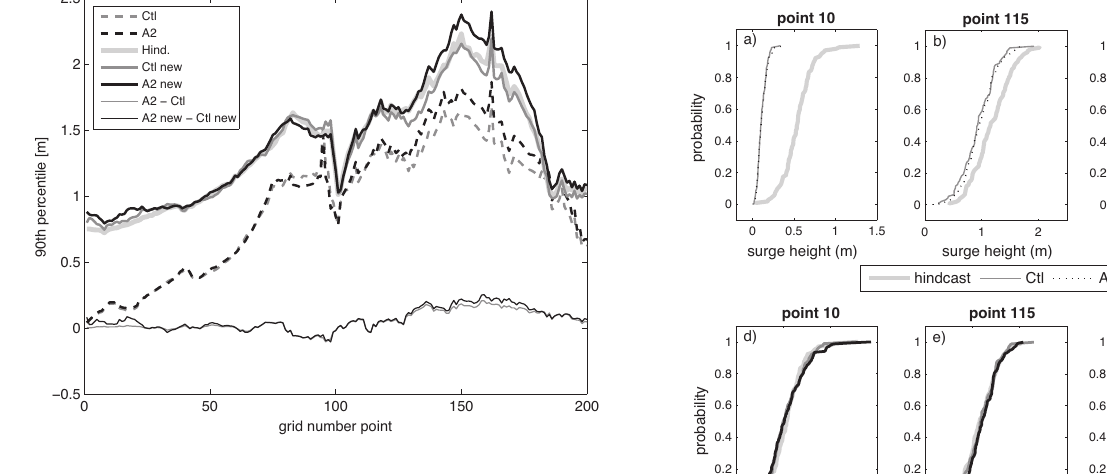
set for the control period agrees better with the hindcast,